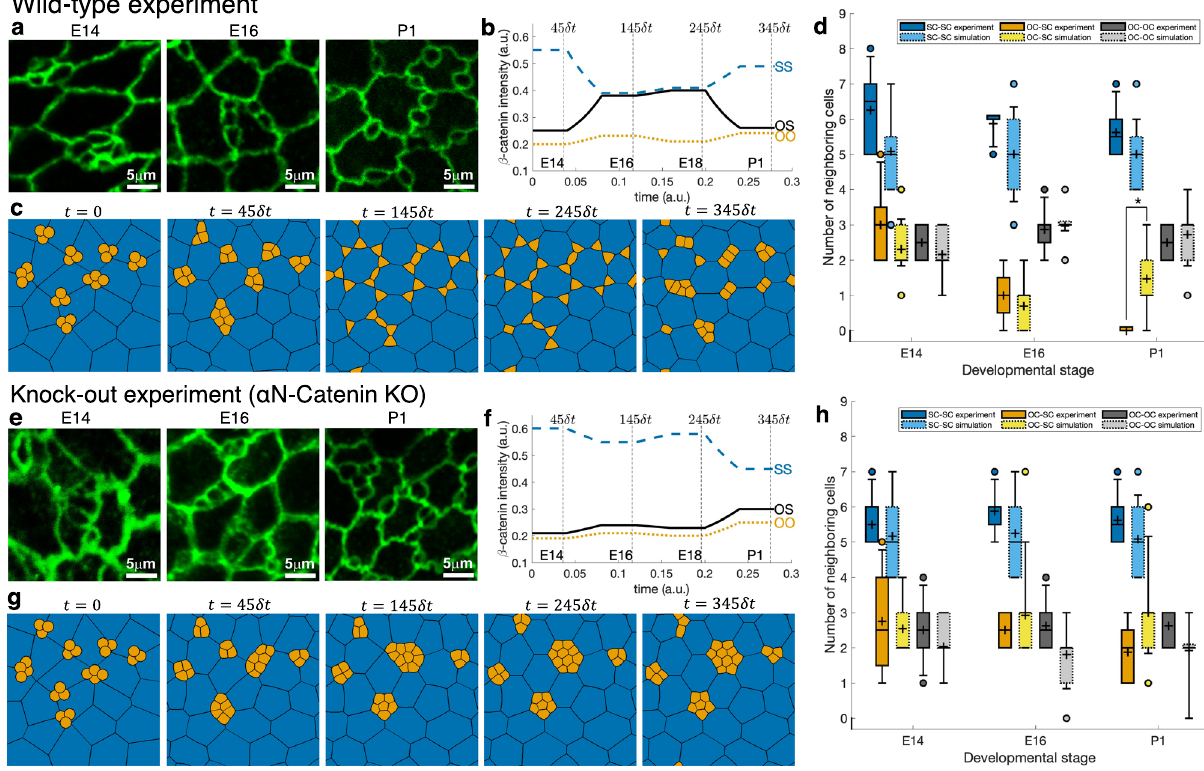
Fig. 3 Actual images and simulation results of a developing olfactory epithelium. a Immunostaining for junctional marker (ZO-1) on the apical surface of the mouse OE from embryonic days (E14, E16) to postnatal day (P1) (reproduced from Journal of Cell Biology, ⓒ 2016 Katsunuma et al. 6 ). Scale bar 5 μ m (all fi gures have the same scale). b Plot of relative intensity of β -catenin accumulations at OO (orange dotted line), OS (solid black line), and SS (blue dashed line) junctions during development, obtained by interpolation of β -catenin intensity mean values at time instants E14, E16, E18, and P1 reported in Fig. S2 of Katsunuma et al. 6 . Moreover, the initial (E14) and fi nal (P1) values were kept constant until the cellular pattern equilibrated (Supplementary Data 1). c A simulation of cellular rearrangement of an olfactory epithelium from initial aggregate of 26 OCs (orange) and 24 SCs (blue) to embryonic stages E14, E16, E18 until postnatal P1 stage obtained by the level set-based model. d Cell neighbor counts obtained from three representative actual images and one simulation image for t = 45 δ t , 145 δ t and 345 δ t shown in ( c ). The boxes in boxplots show fi rst and third quartiles, whiskers show 9th and 91th percentiles and + sign shows the mean. Raw data are provided in Supplementary Data 2. Signi fi cant difference (independent t -test with p = 0.0002, marked by asterisk) was found in OC-OC neighbors at P1 stage ( n = 8 (experiment); n = 24 or n = 26 (simulation)). e – h Corresponding results for α N-catenin KO mouse model based on experimentally measured β -catenin intensities.